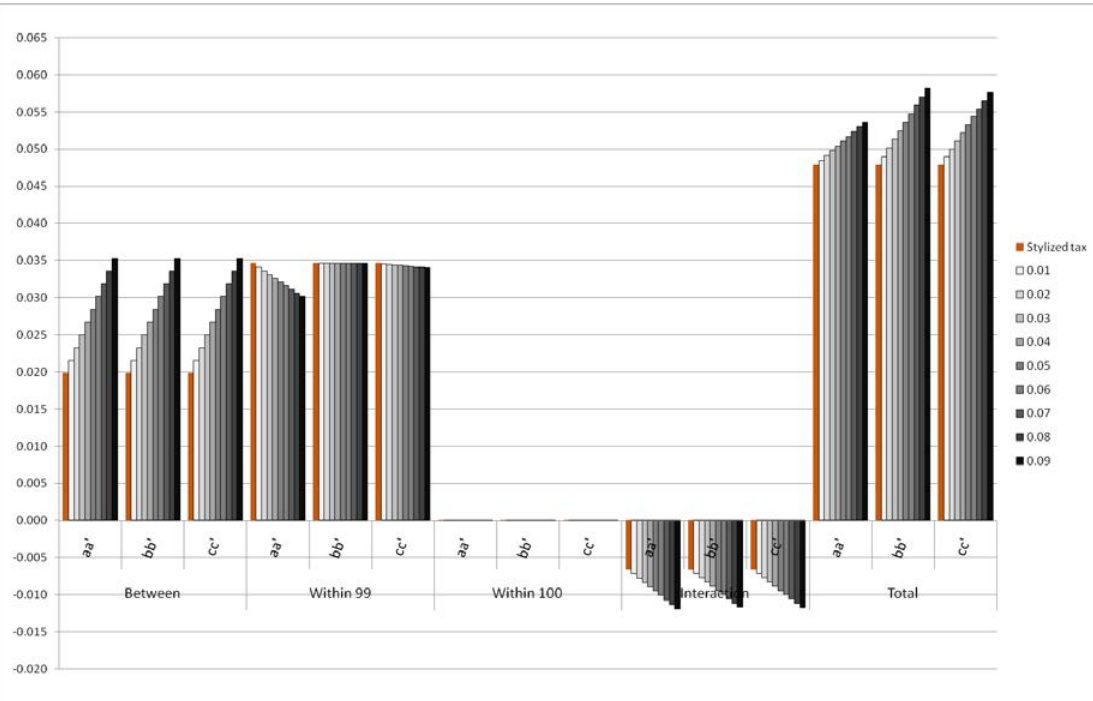
Figure 2: Decomposition of the redistributive